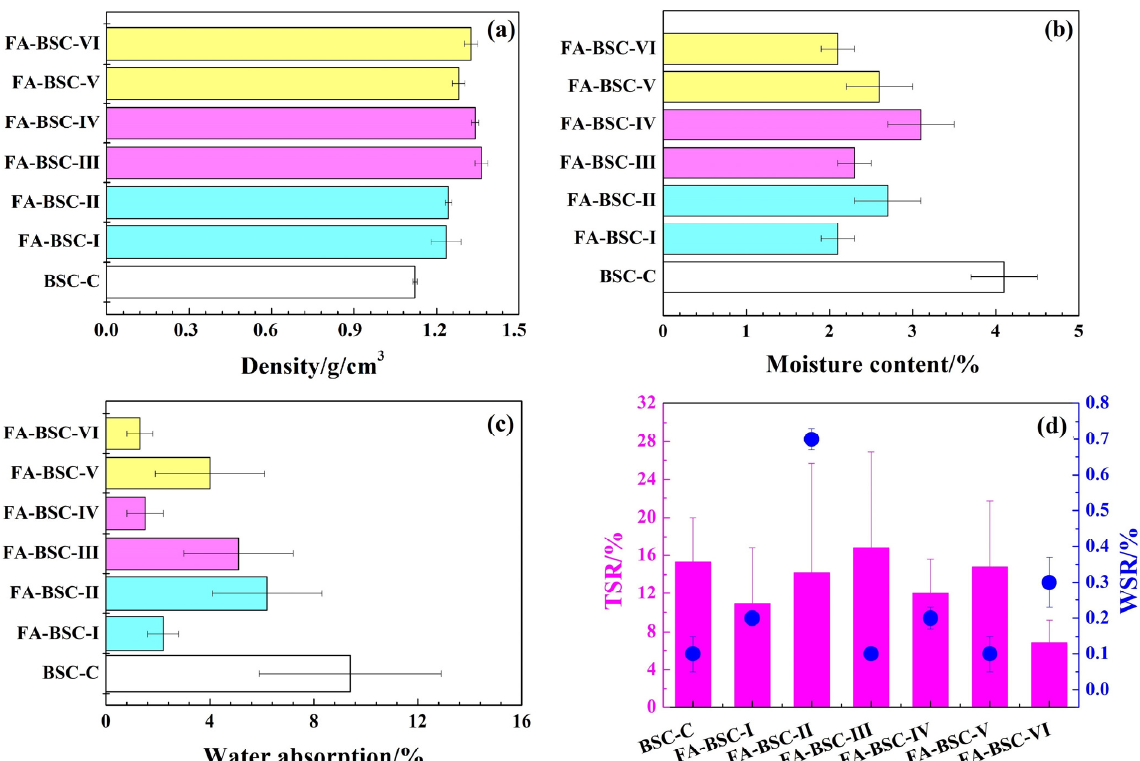
Figure 1. Physical properties of untreated BSC and furfurylated BSC. ( a ) density; ( b ) moisture content; ( c ) water absorption; ( d ) thickness and width swelling rate .